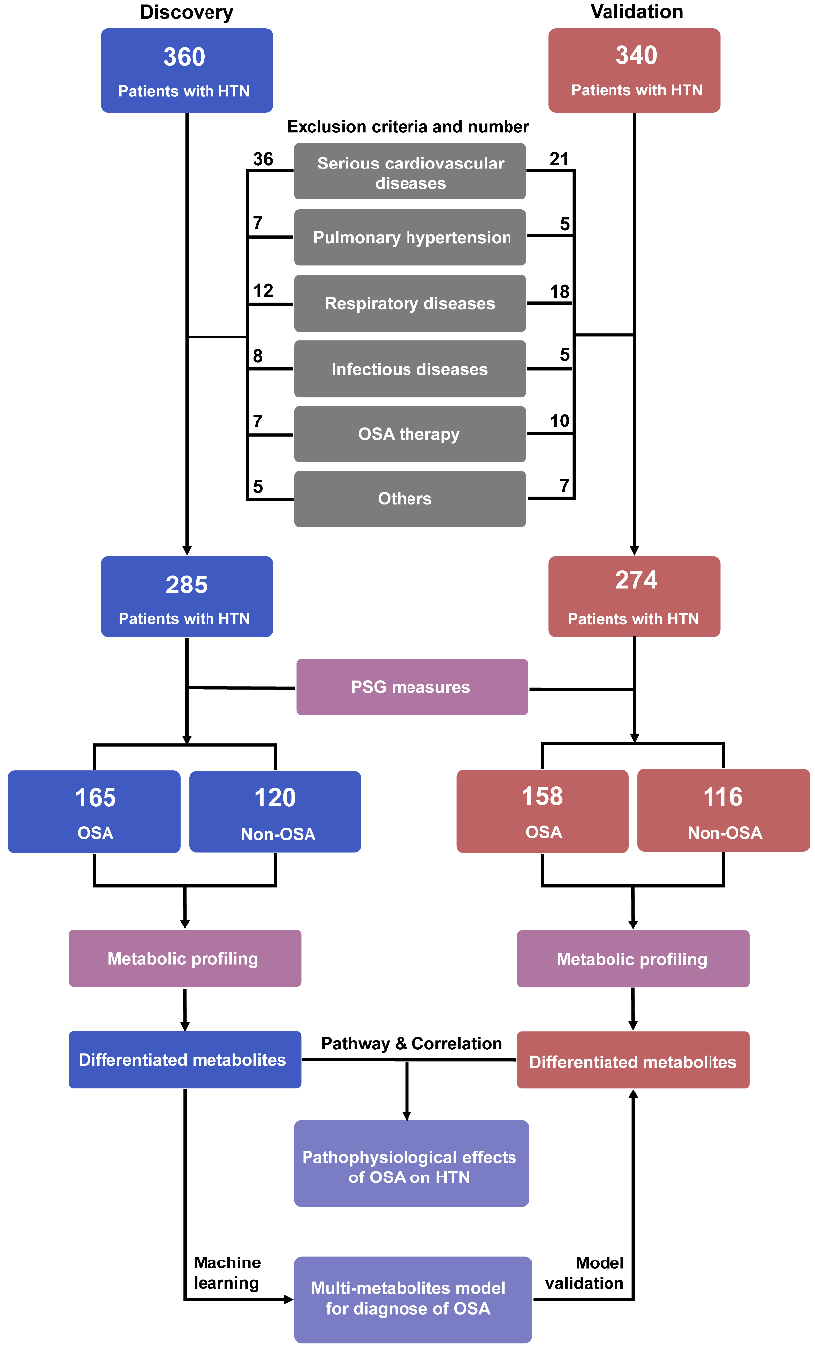
Figure 1. Flowchart of sample selection and study design for the study. HTN, hypertension; OSA, obstructive sleep apnea.